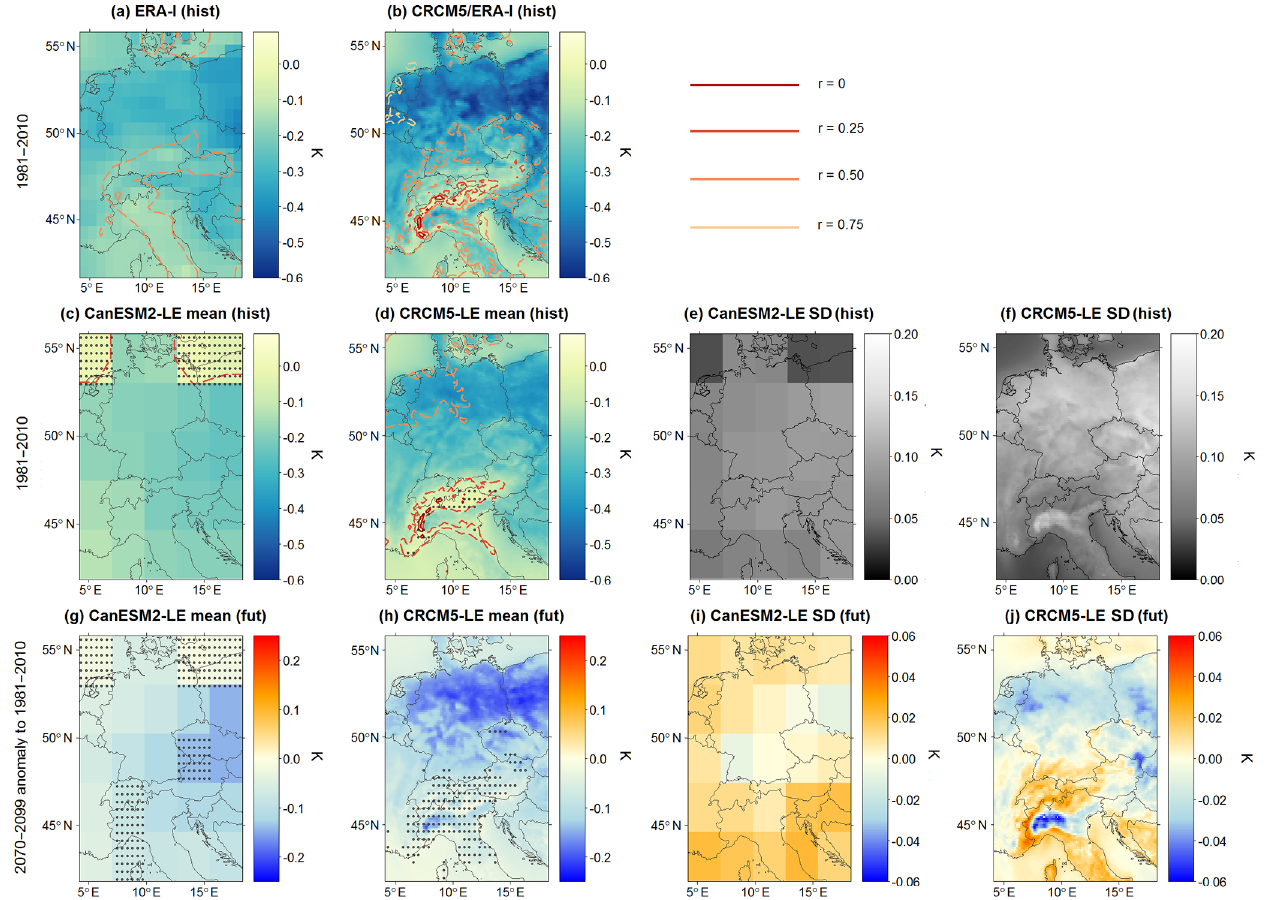
Figure 7. Like Fig. 6 but for nSAT SD ( α 1 in K). Dashed lines of correlation coefficients indicate negative values. Note that the difference maps for CanESM2-LE and CRCM5-LE mean are calculated using absolute